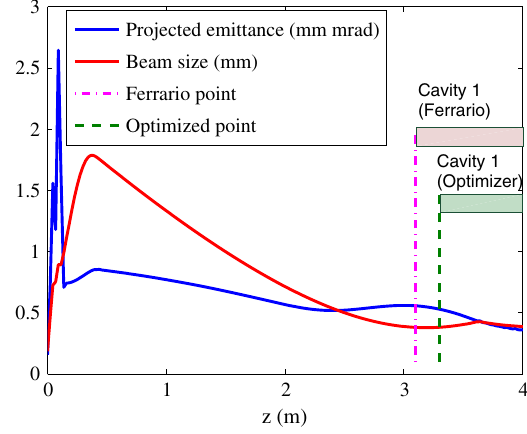
FIG. 8. Beam size and normalized projected emittance along the first part of the SwissFEL photoinjector according to the optimizer. The starting position of the first accelerating cavity found by the optimizer and the one corresponding to the Ferrario condition are also indicated. The PSI gun with 100 MV = m gradient and 910 nm = mm are assumed in the optimization.